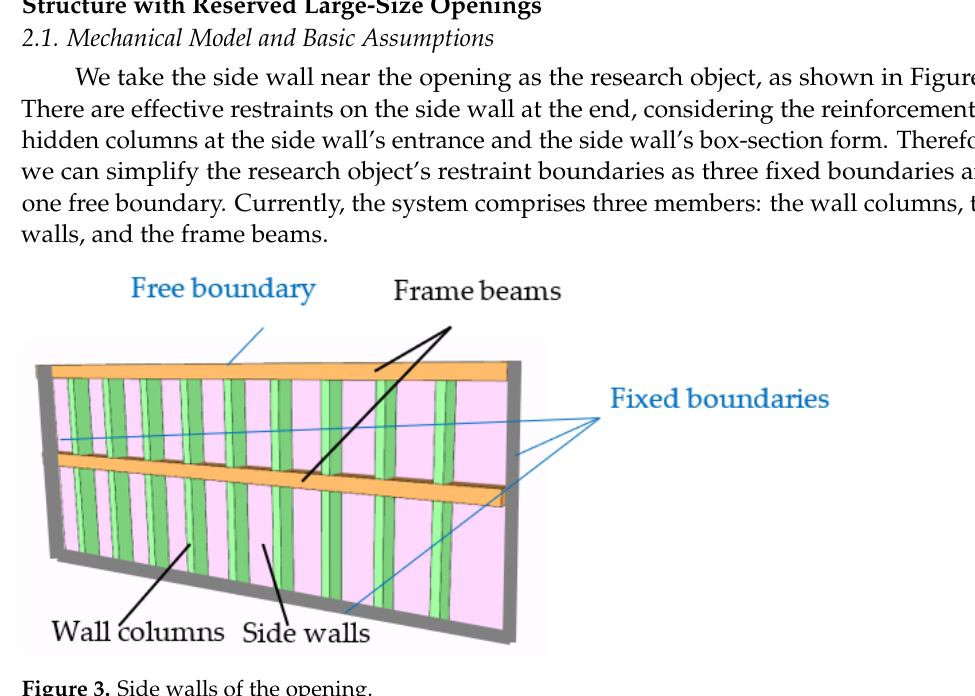
Figure 3. Side walls of the opening